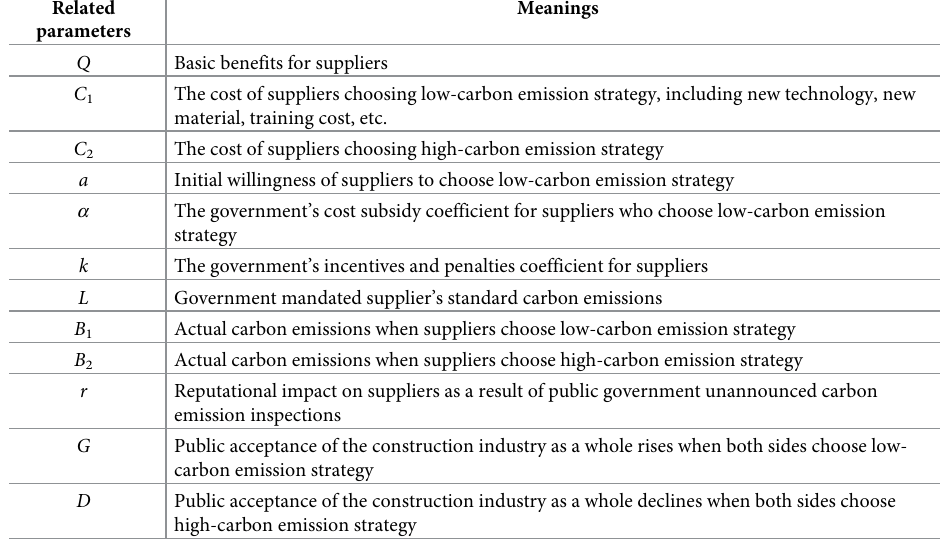
Table 1. Related parameter settings and its